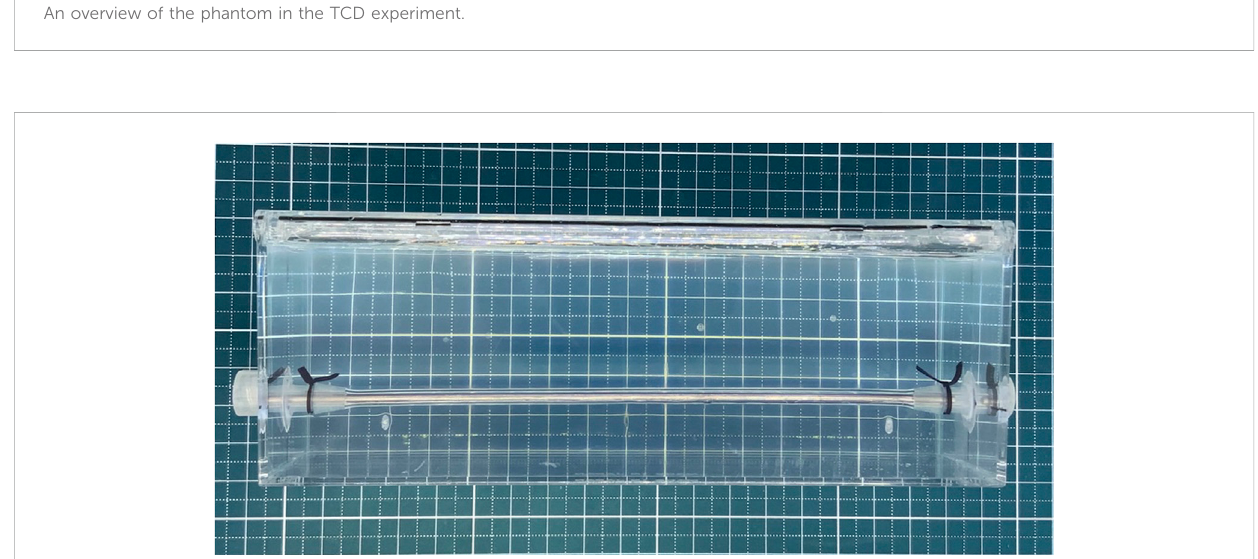
FIGURE 7 An image of the phantom in the study. The smallest squares behind are 5 mm × 5